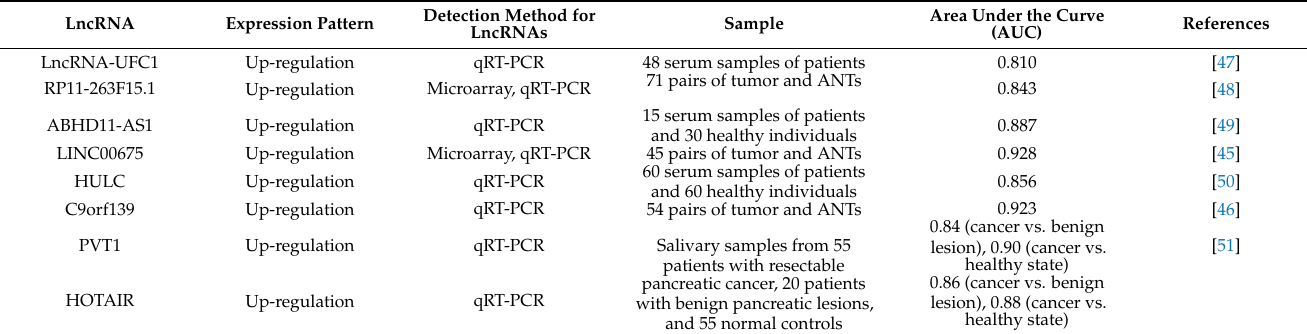
Table 3. Diagnostic role of lncRNAs in pancreatic cancer (ANT: adjacent non-cancerous